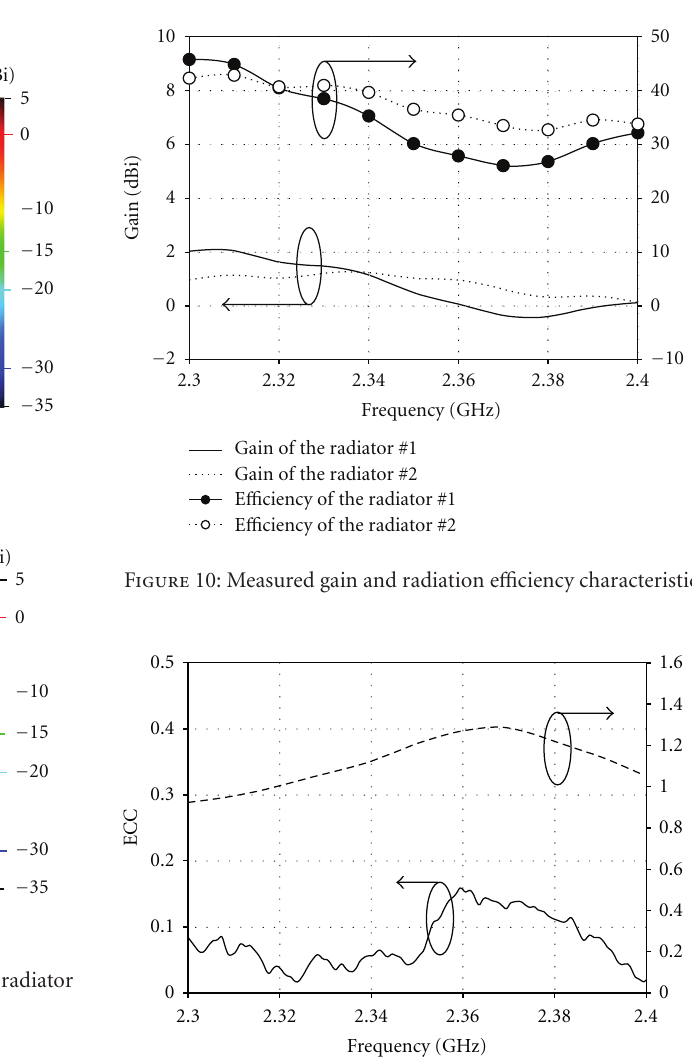
Figure 9. The radiation patterns are symmetrical with respect to the X -axis and each element has near omni-directional radiation patterns at the operating frequency. Figure 10 shows the peak gains and radiation e ffi ciencies of the two elements at the operating frequency. The peak gains were 2.0 dBi and 1.3 dBi, and the measured average radiation e ffi ciencies were 34% and 37%, respectively.